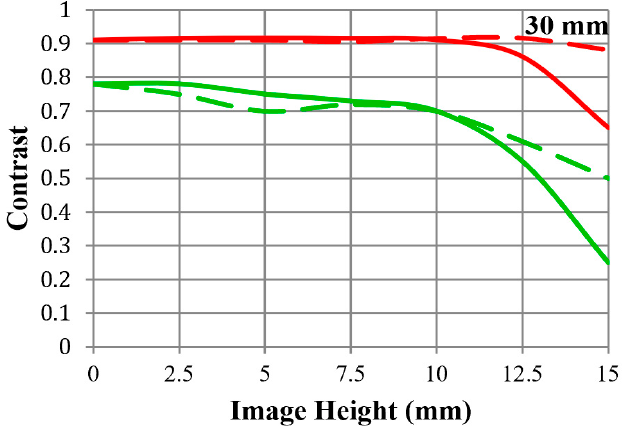
Figure 3. MTF chart